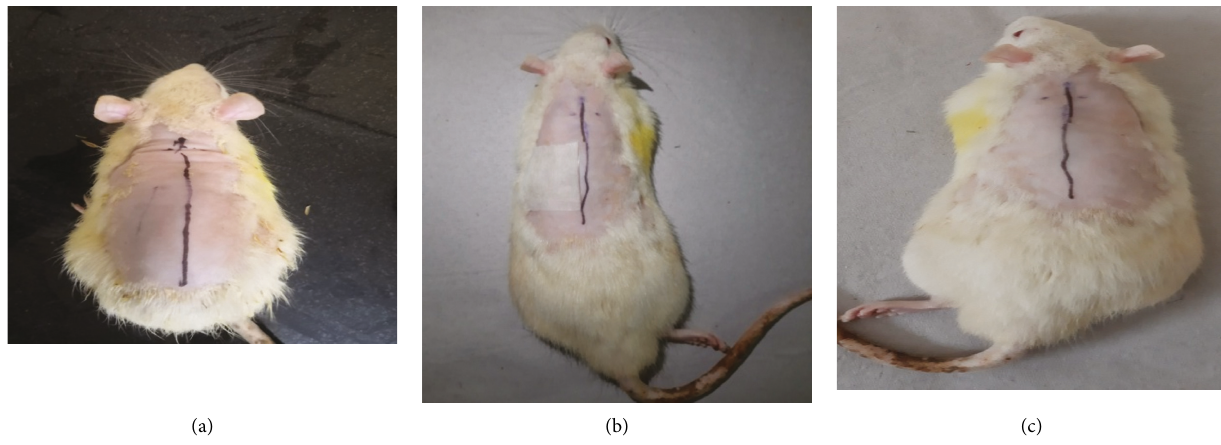
Figure 14: Control: (a) rat skin, (b) skin treated with a microneedle, and (c) skin after 24h.